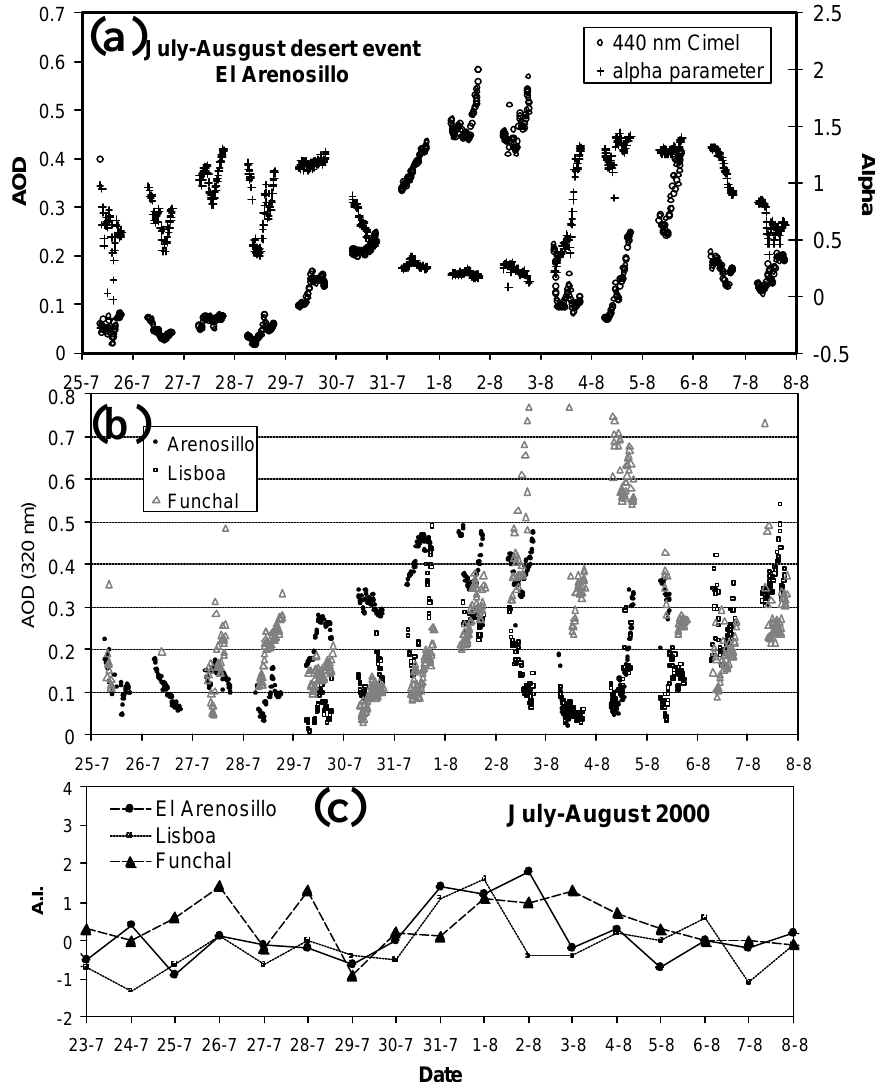
Fig. 6. AOD at 440nm and α evolution at El Arenosillo station for the July-August desert dust event. (b) AOD Brewer data at 320nm for the same event at the three stations. (c) same as (b) but for A.I. values.